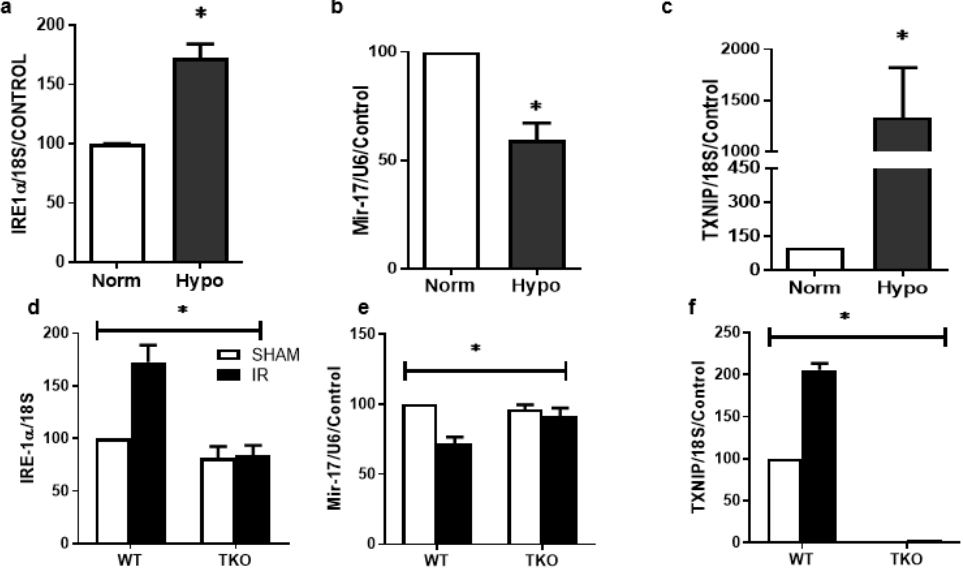
Figure 3. Rat Muller cells (rMC-1) were exposed to hypoxia for 1hour followed by reperfusion in normoxia for 24-hours. Statistical analysis of mRNA level assessed by realtime-PCR showed a significant increase in ER-stress marker IRE-1  ( a ), decrease in miR-17-5p ( b ), Marked increase (20- fold) in TXNIP mRNA ( c ) compared to cells grown in normoxia. (p<0.05 vs normoxia, N =